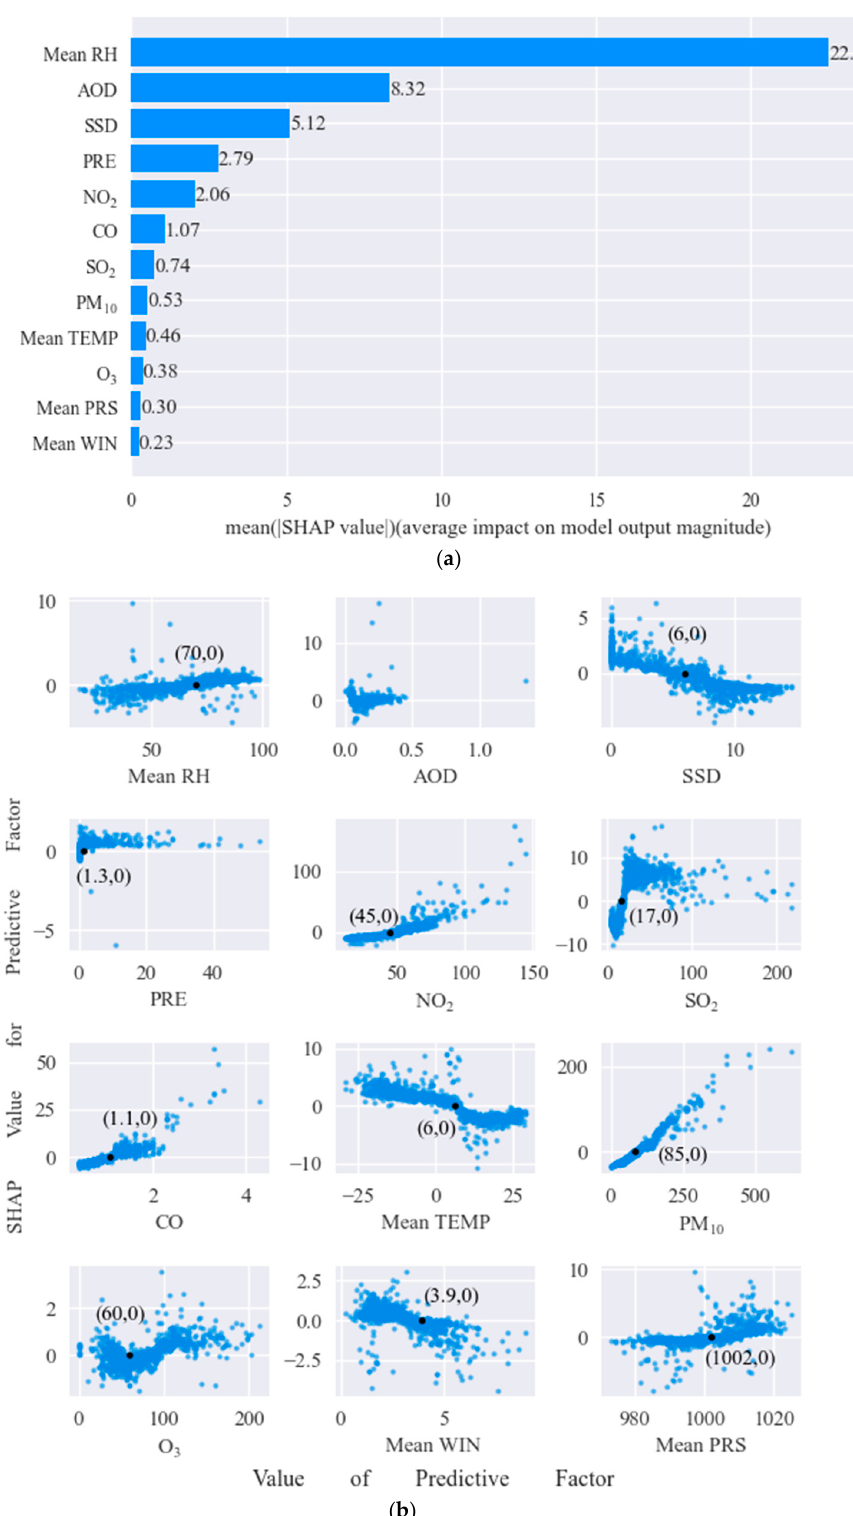
Figure 4. Contribution of features to predicted values. ( a ) Ranking of feature contributions. ( b ) Variation of feature influence.